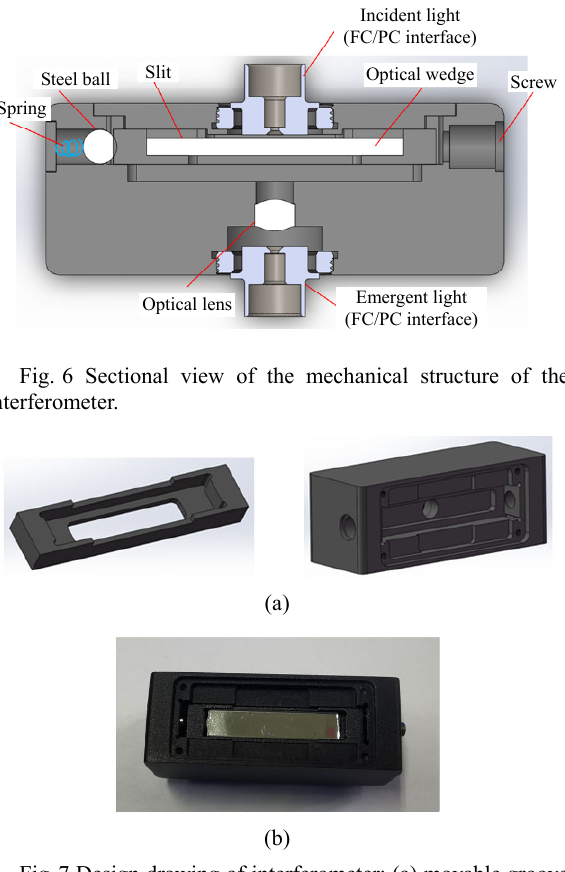
Fig. 7 Design drawing of interferometer: (a) movable groove and internal engineering drawing of interferometer and (b) physical image inside the